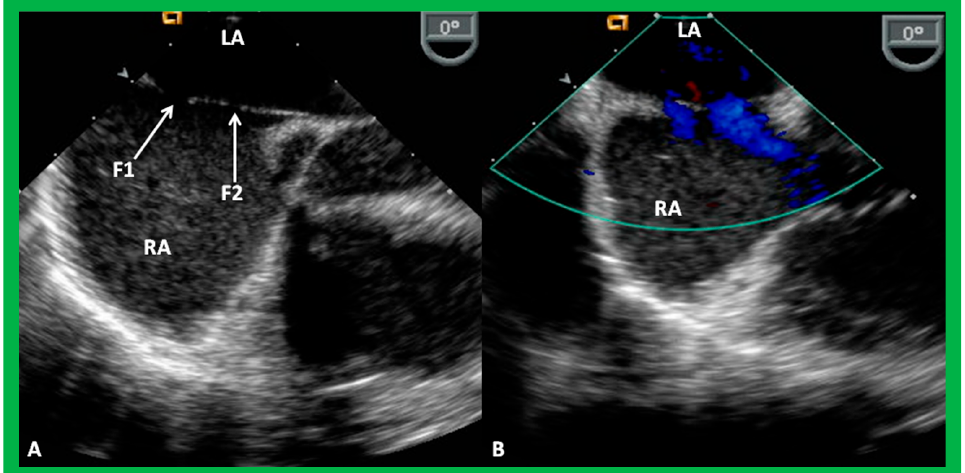
Figure 31. Transesophageal echocardiographic pictures of the fenestrated atrial septal defect by two- dimensional (2D) ( A ) and color Doppler ( B ) imaging. Note the fenestrations (F1 and F2) within the atrial septum in ( A ) and shunting from the left atrium (LA) to the right atrium (RA) in ( B ). Repli- cated from Reference [7].